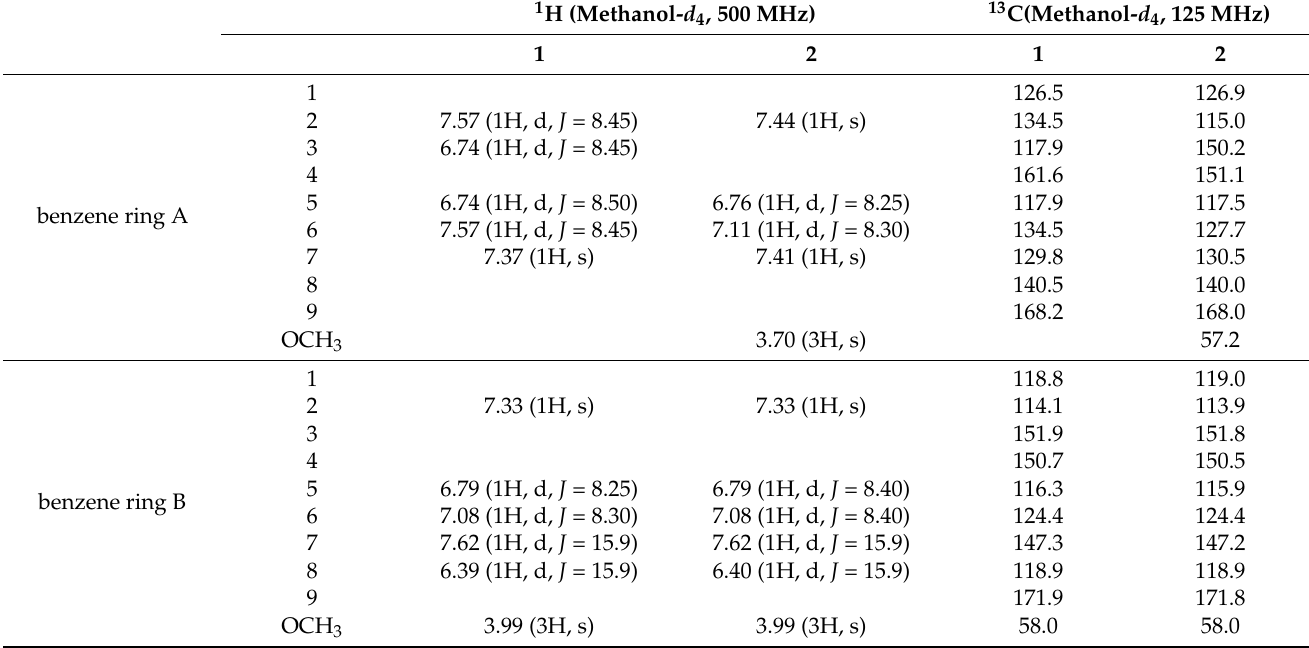
Table 1. NMR data for compounds 1 and 2